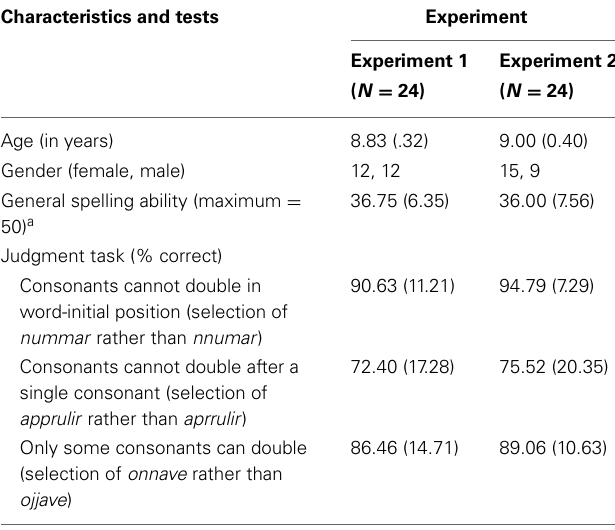
Table 1 | Characteristics (age and gender) and scores on the general spelling ability and judgment tasks (standard deviations in